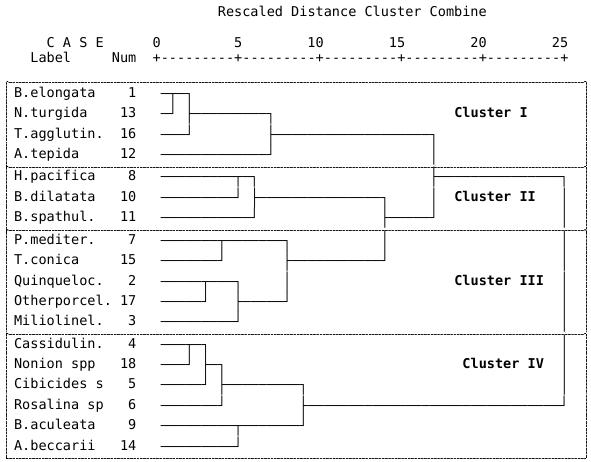
Fig. 9. R-mode cluster analysis for the entire dataset of the two